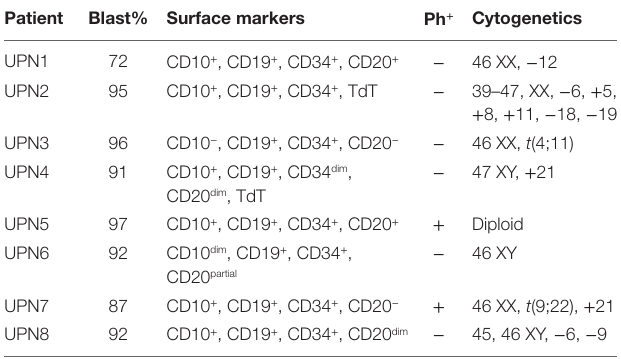
TaBle 1 | Patient